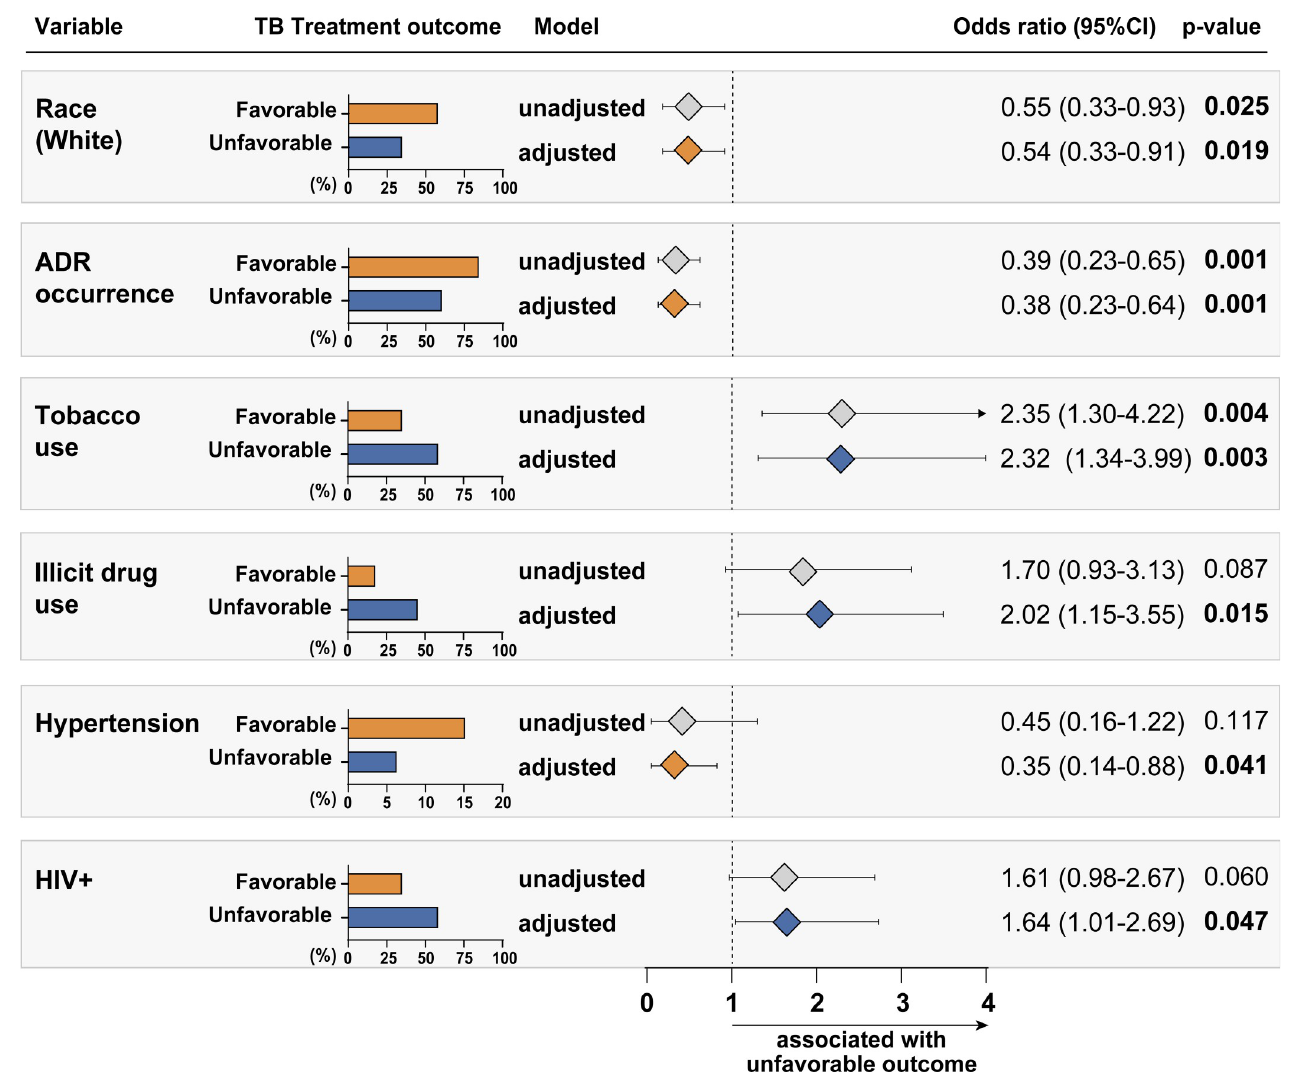
Fig 2. Association between clinical characteristics and tuberculosis treatment outcomes among tuberculosis patients. The logistic binary regression model (backward stepwise regression) was performed to evaluate the independent associations between clinical characteristics, including adverse drug reaction occurrence, of tuberculosis patients and variables showed in the univariate analyses (Table 1) and unfavorable treatment outcome. Only variables remaining in the final model are shown. Abbreviation: ADR: adverse drug reaction; CI: confidence interval; TB: tuberculosis.